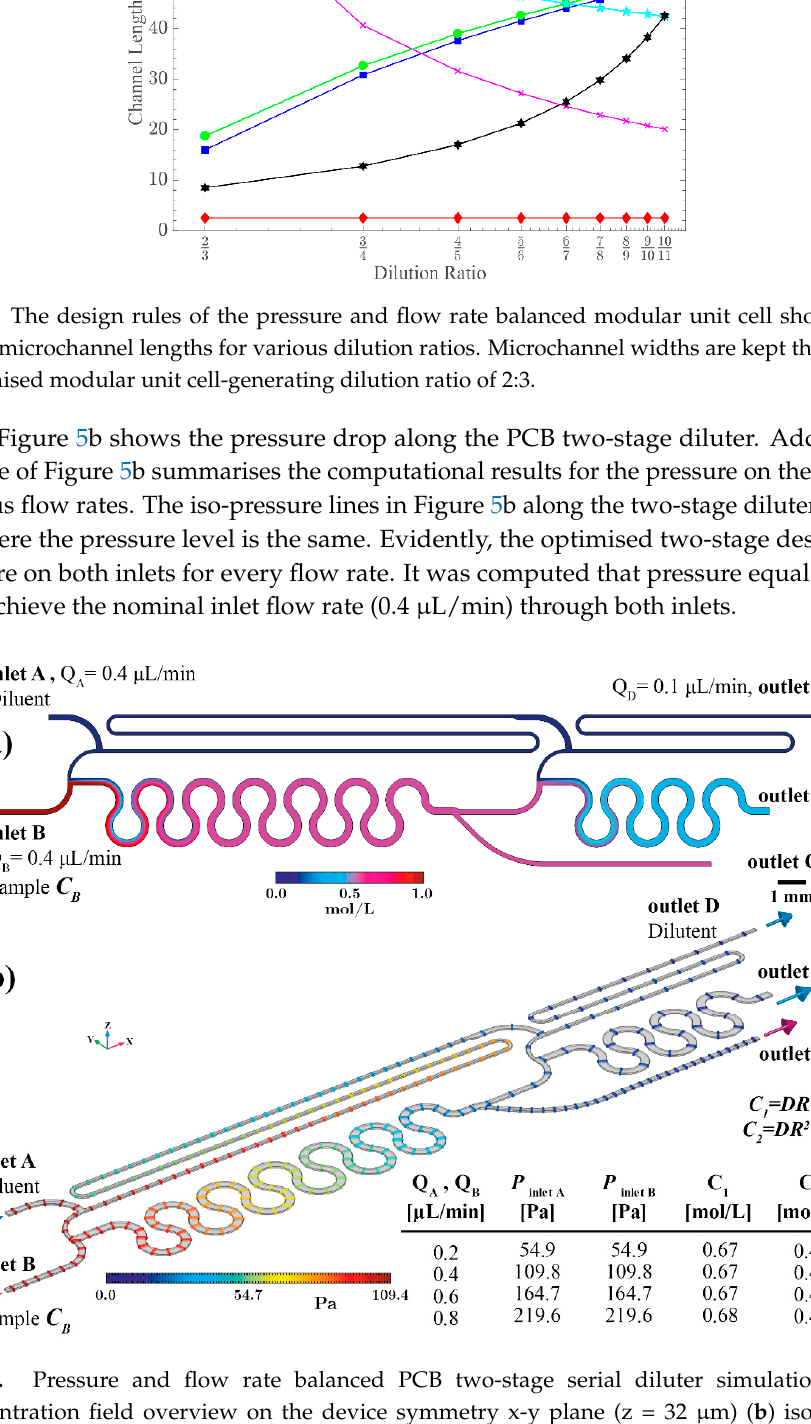
Figure 5. Pressure and flow rate balanced PCB two-stage serial diluter simulation results. ( a ) concentration field overview on the device symmetry x-y plane (z = 32 μ m) ( b ) iso-pressure surfaces. The